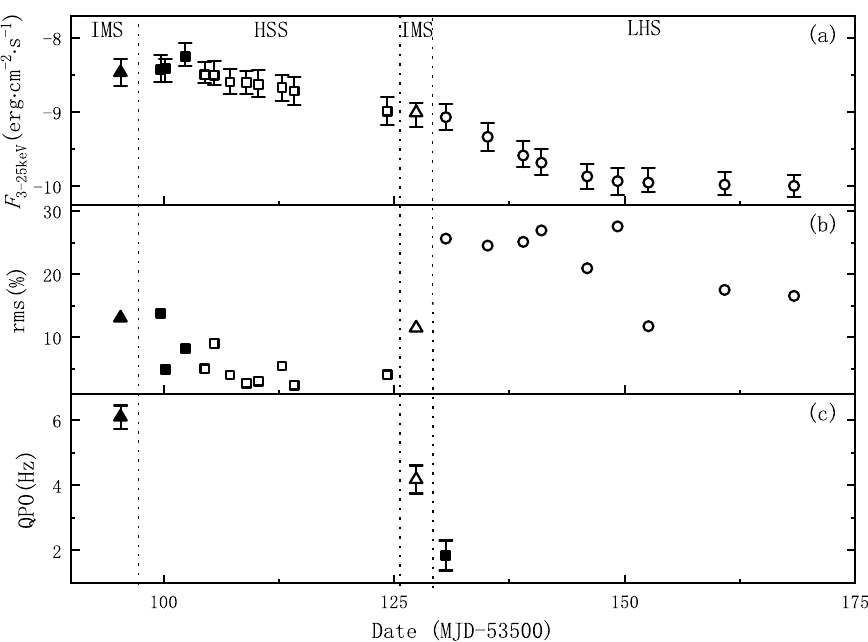
Figure 3. The evolution of 3–25 keV X-ray flux, rms and QPOs of H 1743-322 during the ”faint” 2005 outburst. The symbol types are the same as Figure